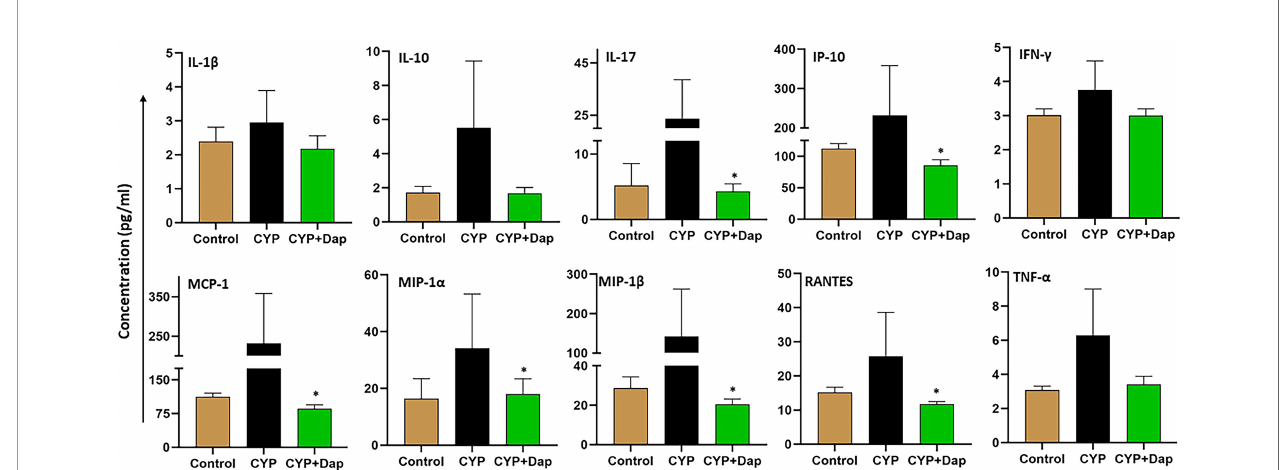
FIGURE 7 | Dap reduces levels of systemic pro-in fl ammatory cytokines and chemokines in CYP-induced IC. Whole blood was collected from mice in the three groups at the experimental endpoint and sera were produced by centrifugation. Sera were analyzed by ELISA assay for CYP-induced in fl ammatory cytokines and chemokines IL-1 b , MIP-1 a , IFN- g , RANTES, IL-17, MCP-1, IP-10, MIP-1 b , IL-10, and TNF- a . Treatment of CYP+vehicle induced systemic in fl ammatory cytokines, while treatment with CYP+Dap suppressed their expression. Data represent the concentration of in fl ammatory cytokine and chemokines ± SEM from the three independent experiments. Asterisks indicate statistically signi fi cant differences between CYP+vehicle and CYP+Dap treatment groups (*p < 0.05).